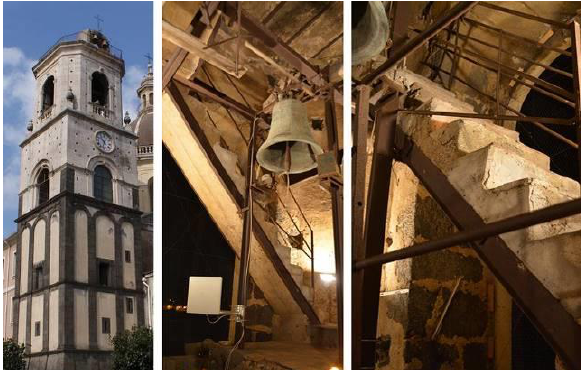
Figure 8. The bell tower of San Filippo in Aci San Filippo (Aci Catena - Ct). Stairs with NP iron beams.